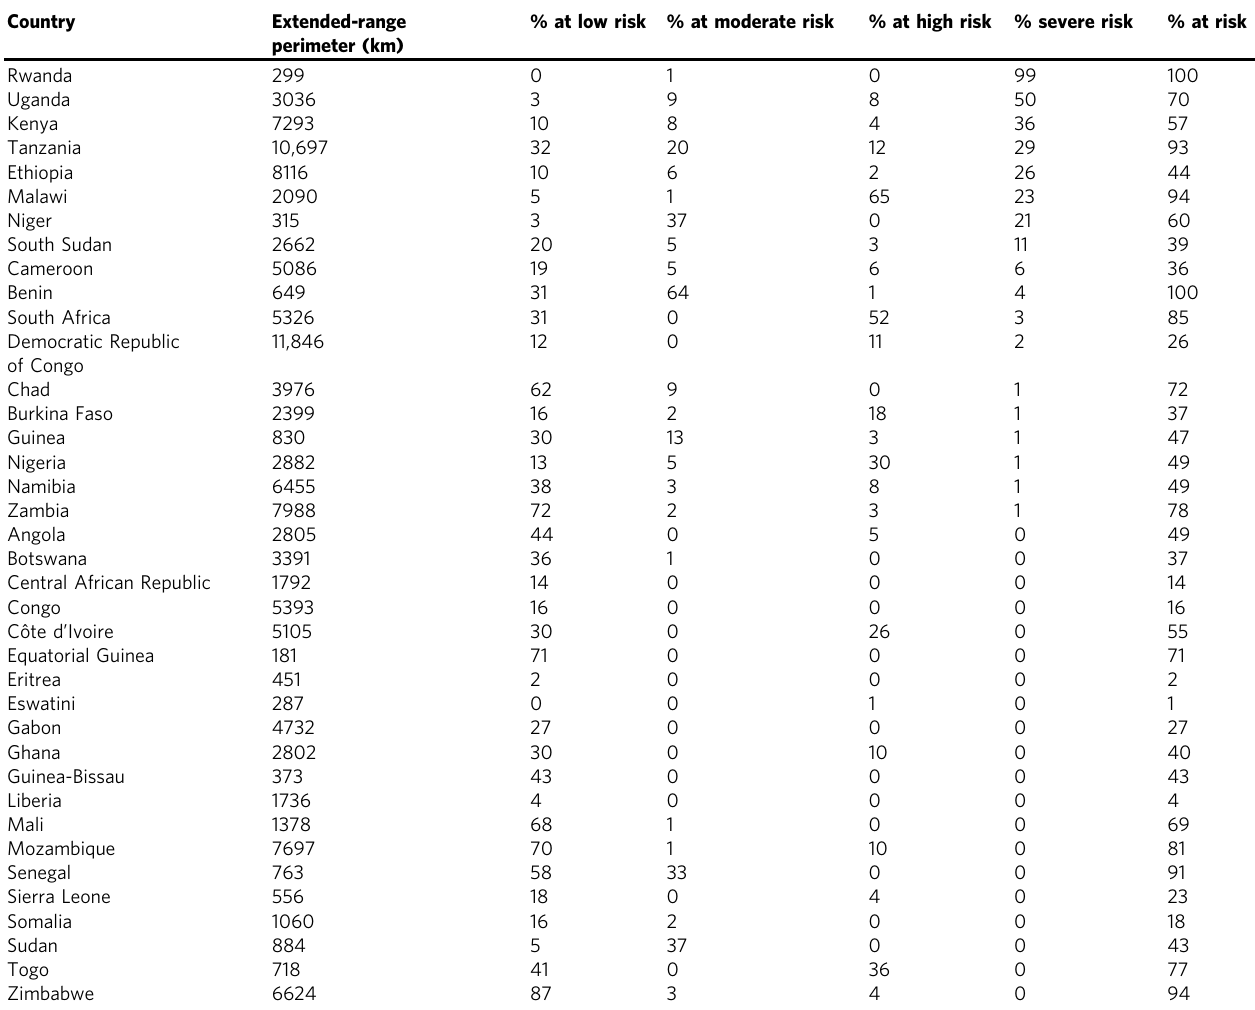
Table 1 Percentage of the extended ranges of African lions ( Panthera leo ) and African elephants ( Loxodonta africana and Loxodonta cyclotis ) under different risk of con fl ict with humans. Country Extended-range perimeter